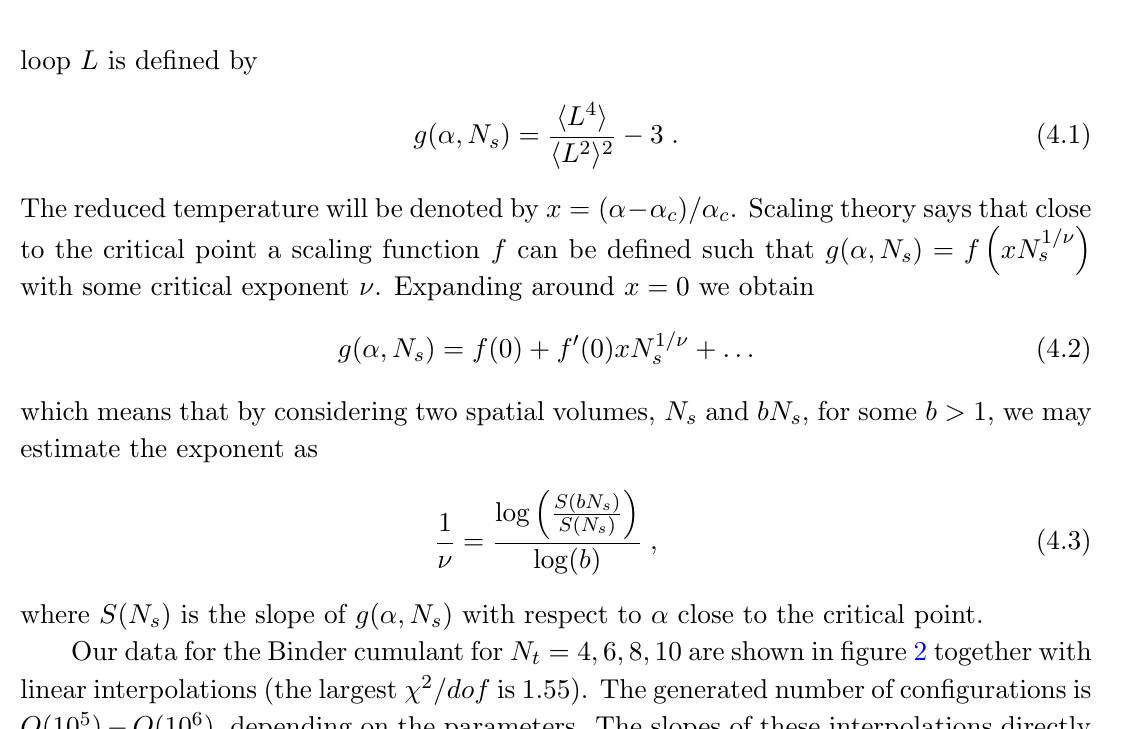
Figure 2 . The measured Binder cumulants of the Polyakov loop and linear interpolations close to the critical points with the topological